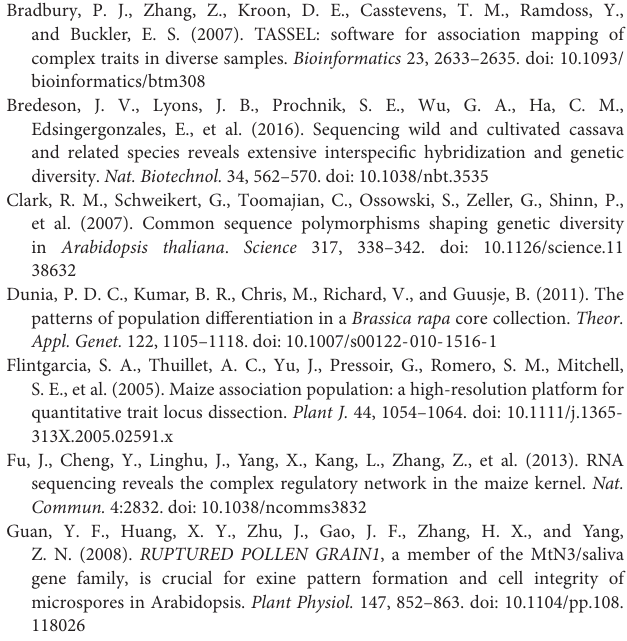
shown in a black dashed vertical line. Genome-wide significance threshold is depicted in blue horizontal dashed line. Annotated candidate genes are indicated in pink boxes below the graph. TABLE S1 | List of cassava samples with the origin. TABLE S2 | Total reads in each accession. TABLE S3 | Summary of the number of SNPs mapped onto each chromosome. TABLE S4 | Summary of the PIC values in different chromosomes of the cassava. TABLE S5 | Phenotypic variations for 11 traits in this cassava